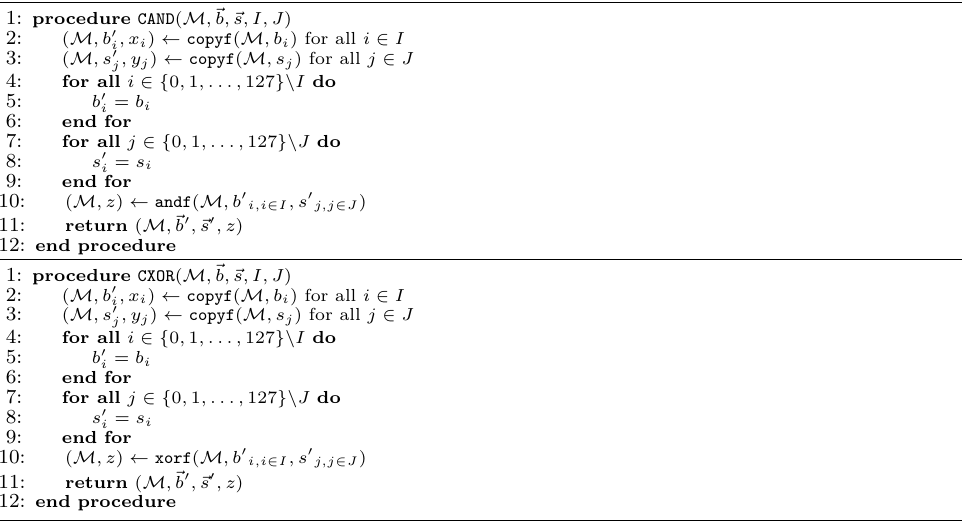
Algorithm 8 MILP model for COPY+XOR and COPY+AND in